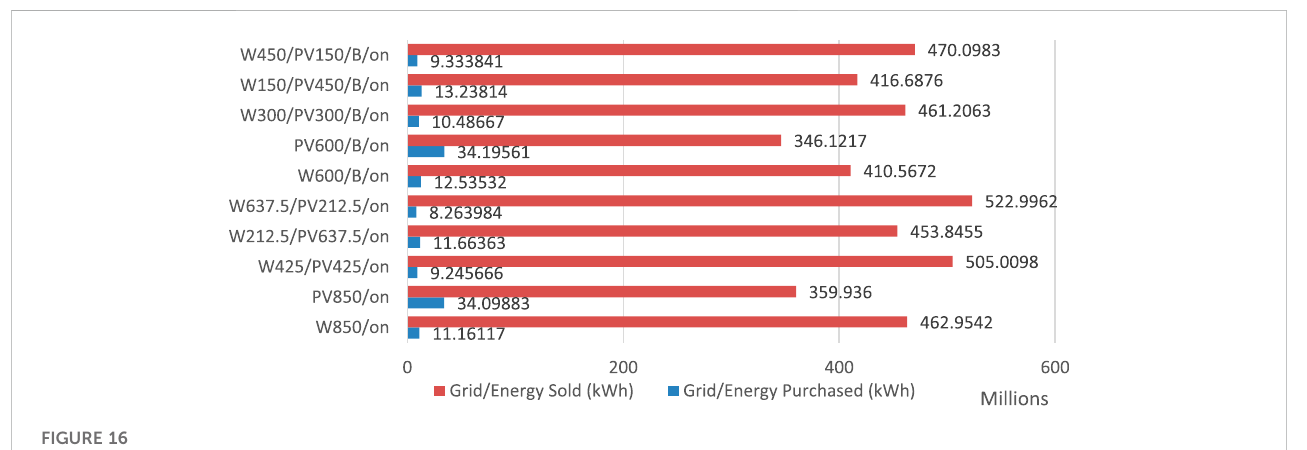
FIGURE 15 Excess electricity production of all systems.